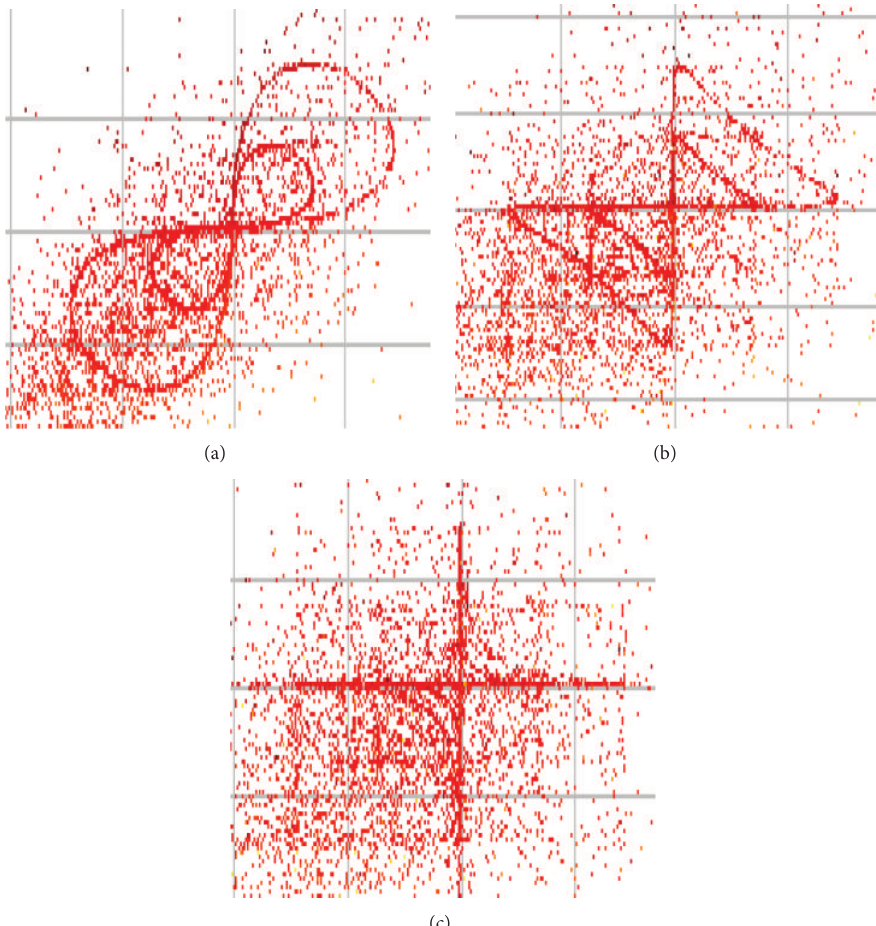
Figure 6: (a) The phase diagram for 𝑡 = 1 , (b) the phase diagram for 𝑡 = 2 , and (c) the phase diagram for 𝑡 = 3 . (The horizontal axis and vertical axis are, respectively, 𝑥(𝑡) -DTG and 𝑥(𝑡 + 1) -DTG, the colour indicated the dimension).